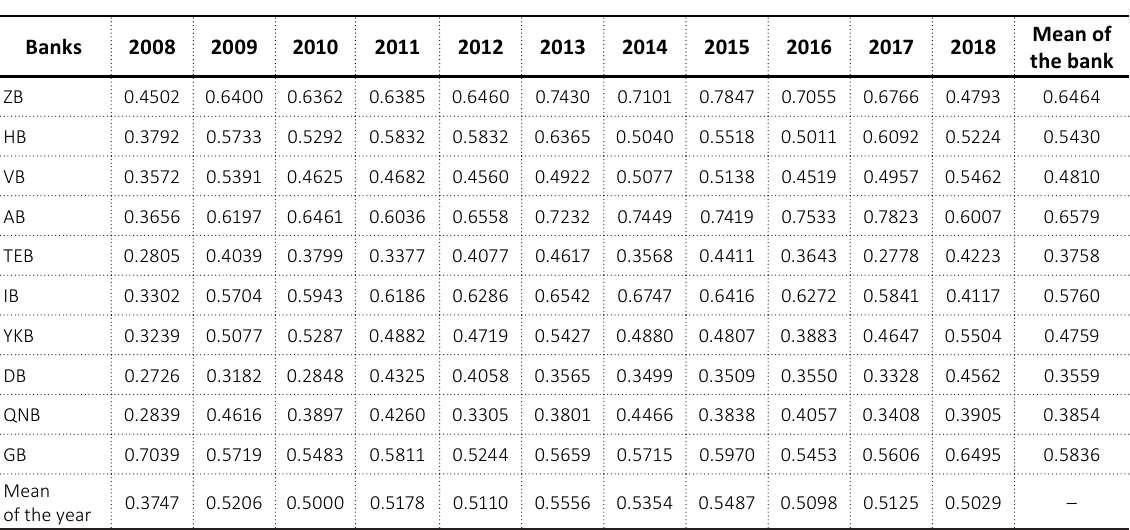
Table 9. Performance scores of the second